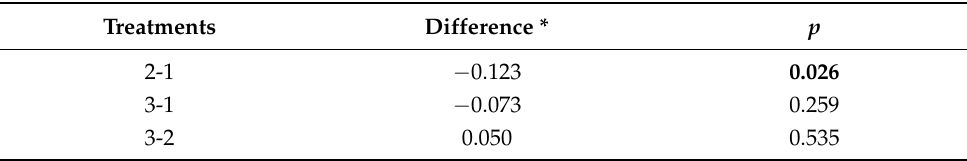
Table 2. Tukey HSD post hoc test results for residual adhesive volume.